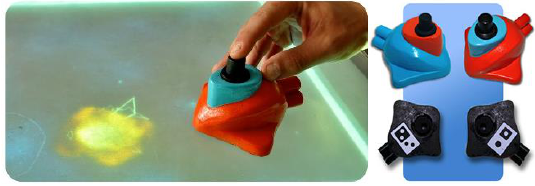
Figure 4. Asteroids